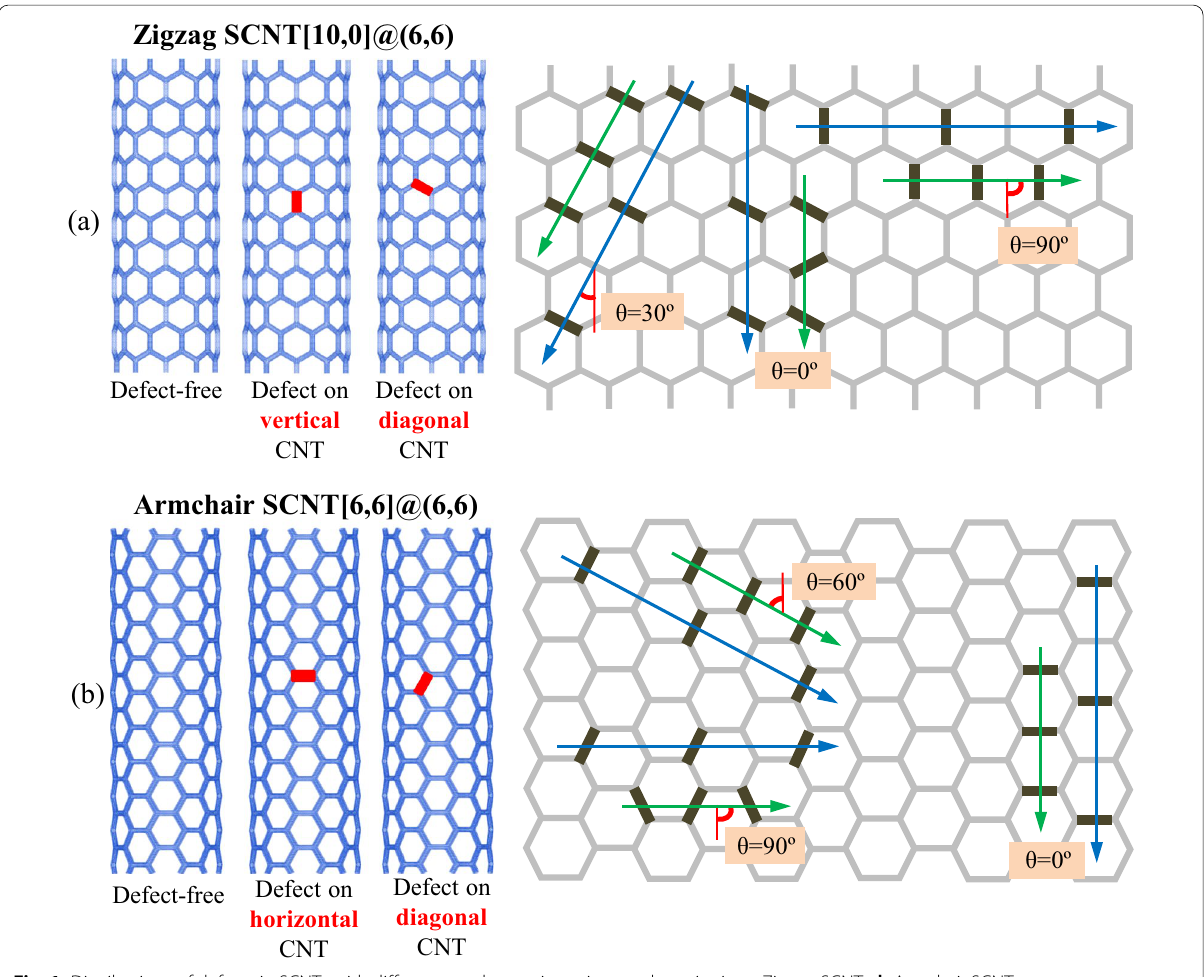
Fig. 1 Distributions of defects in SCNTs with different numbers, orientations and continuity. a Zigzag SCNTs; b Armchair SCNTs